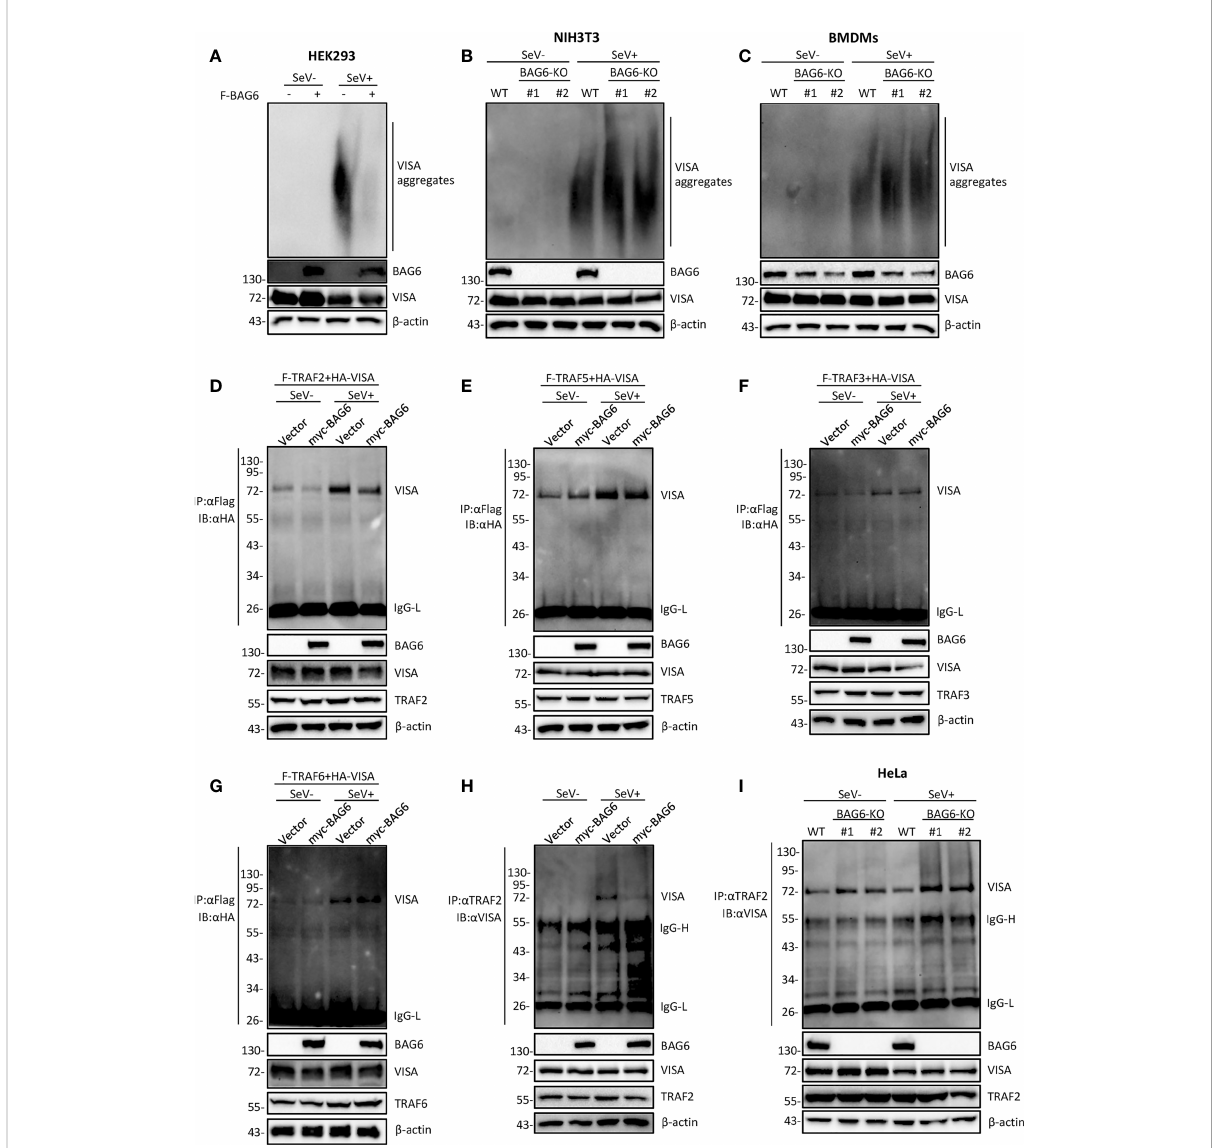
FIGURE 5 BAG6 regulates the aggregation and recruitment of downstream signaling molecules of VISA. (A) Overexpression of BAG6 inhibits SeV-induced aggregation of VISA. HEK 293 cells (2×10 6 ) were transfected with vector or Flag-BAG6 for 20 h, and cells were infected with SeV (MOI = 1) for 8 h before harvest. Then, the lysates were fractionated by SDD-AGE and SDS-PAGE before immunoblotting analysis. (B) BAG6-de fi ciency increases SeV-induced aggregation of VISA in NIH3T3 cells. Wild type and BAG6-de fi cient NIH3T3 cells were untreated or treated with SeV (MOI = 1) for 8 h before harvest. Then, the lysates were fractionated by SDD-AGE and SDS-PAGE before immunoblotting analysis. (C) BAG6- de fi ciency increases SeV-induced aggregation of VISA in BMDMs. Wild-type BMDMs were infected with lentivirus containing BAG6-CRISPR Cas9 sgRNA for 48 h before viral infection. Wild type and BAG6-de fi cient BMDMs cells were untreated or treated with SeV (MOI = 1) for 8 h before harvest. Then, the lysates were fractionated by SDD-AGE and SDS-PAGE before immunoblotting analysis. (D – G) Overexpression of BAG6 inhibits the interaction of VISA and TRAF2 speci fi cally. HEK 293 cells (2×10 5 ) were transfected with the indicated plasmids for 22 h, and cells were untreated or treated with SeV (MOI = 1) for 10 h following co-immunoprecipitation and Western bolting analysis. (H) Overexpression of BAG6 impairs the endogenous interaction of VISA and TRAF2. HEK 293 cells (4×10 6 ) were transfected with the indicated plasmids for 22 h, and cells were untreated or treated with SeV (MOI = 1) for 10 h following co-immunoprecipitation and Western bolting analysis. (I) BAG6-de fi ciency increases the endogenous interaction of VISA and TRAF2. Wild type and BAG6-de fi cient HeLa cells (1×10 7 ) were untreated or treated with SeV (MOI = 1) for 10 h before co-immunoprecipitation and Western bolting